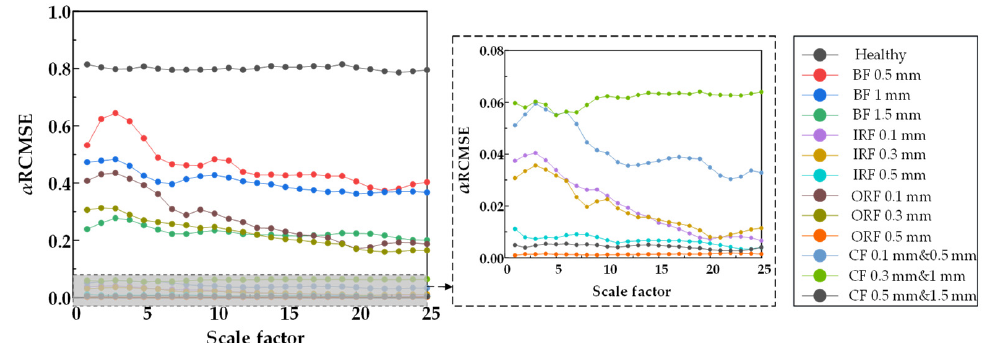
Figure 23. α RCMSE entropy values of 25 scale factors under different damage degrees.